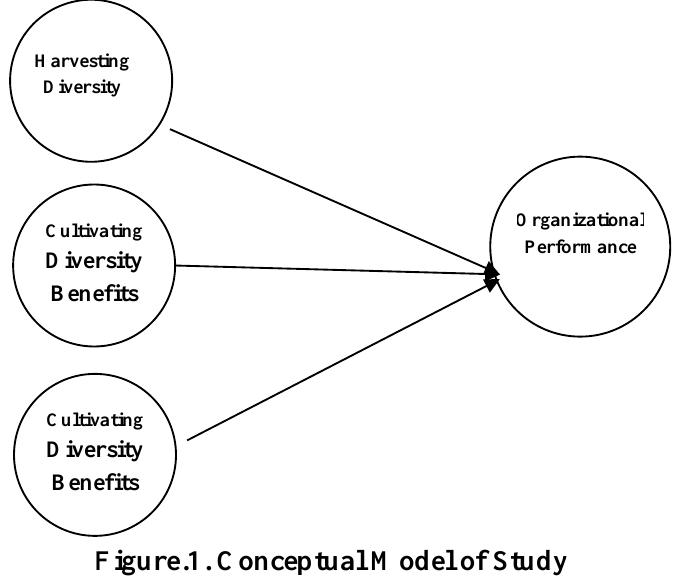
Figure.1. Conceptual Model of